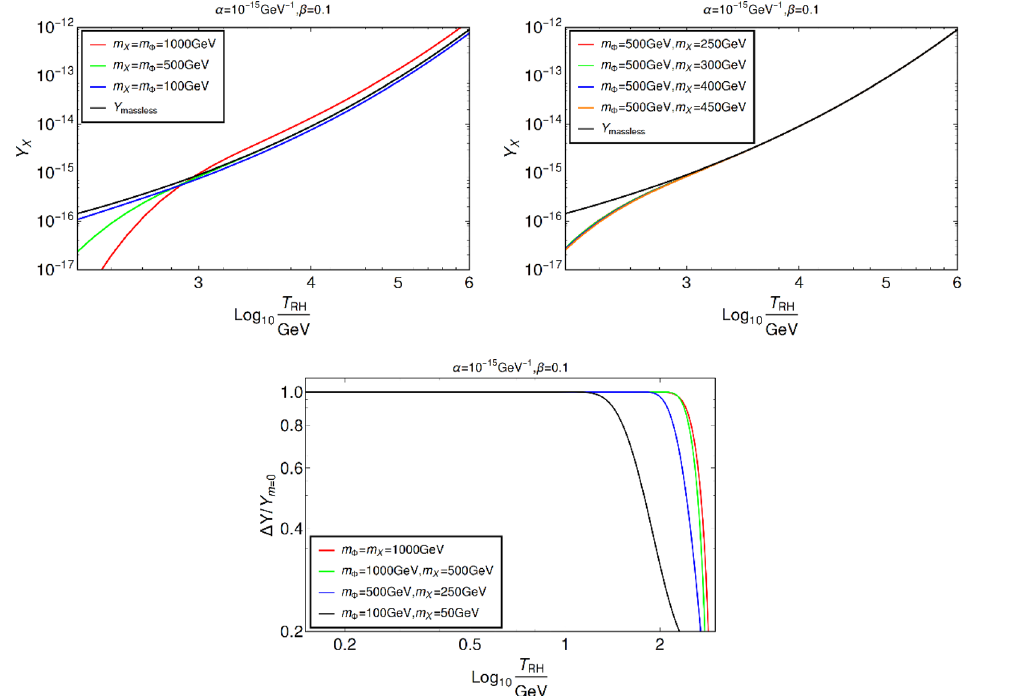
Figure 5 . Top panels: comparison of the yield at T EW in the massive case versus that in the massless case with respect to the reheat temperature, where the red, green and blue curves correspond to the massive cases while the black curve represents the massless case. Bottom panel: Variation of ∆ Y/Y m =0 with the reheat temperature for different choices of the masses shown in different colors. In all the plots “massless” refers to → m = 0